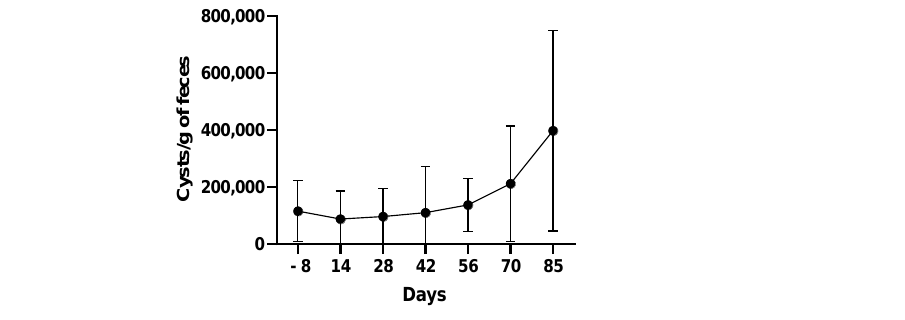
Figure 1. G. intestinalis cysts enumeration in fecal samples. Values are mean ± SEM. G. intestinalis genotyping may reveal different results depending on the genetic locus sequenced and multiple gene loci should be investigated to increase the specificity of the results [39]. Thus, we determined G. intestinalis assemblages in samples D − 8 and D85 by sequencing gdh , tpi , β -giardin , and SSU rRNA genes (Table 2). All animals were infected by dog-specific assemblages C and/or D. The majority of puppies have mixed infections between assemblages in both D − 8 and D85. No zoonotic A or B assemblages were detected in this study. Table 2. Number of G. intestinalis assemblages sequenced at gdh , tpi , β -giardin, and SSU rRNA loci. Gene Loci